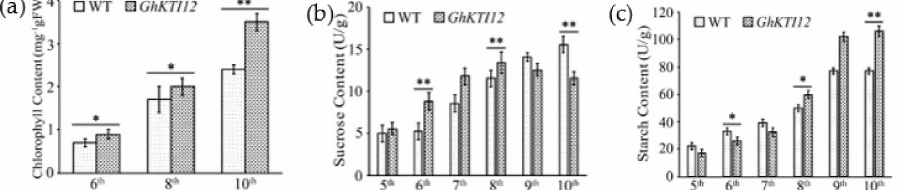
Figure 5. Contents analysis of chlorophyll, sucrose and starch in GhKTI12 transgenic tobacco leaves. ( a ) Chlorophyll content in GhKTI12 transgenic plants and wild-type plants (n = 10). ( b ) Sucrose content in leaves at different leaf ages. ( c ) Starch content in leaves at different leaf ages. All data were taken from T2 generation. Bars in the graph show the standard mean error. Asterisks indicates significant differences between wild type (WT) and GhKTI12 transgenic plants analyzed by Student’s t -test, (*) p < 0.05; (**) p <